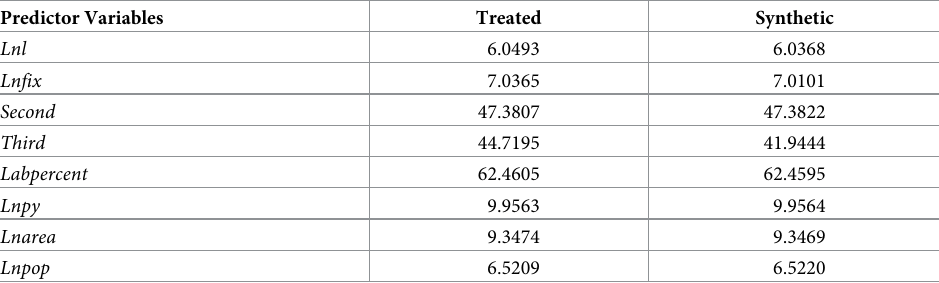
Table 10. Comparison of the treated and synthetic predictors of Log (GDP industry).